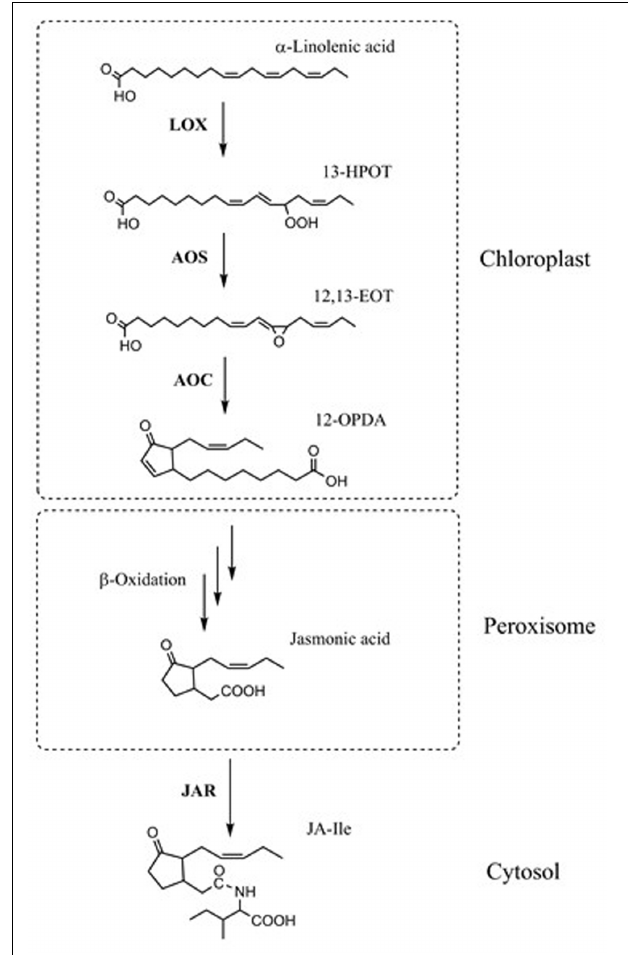
FIGURE 1 | Simplified JA biosynthetic pathway. α -Linolenic acid is oxygenated by 13-lipoxygenases (LOXs). In the 13-LOX pathway, the product (13 S )-hydroperoxy-octadecatrienoic acid (13-HPOT), is a substrate for allene oxide synthase (AOS). AOS converts 13-HPOT to (12,13 S )-epoxyoctade catrienoic acid (EOT). Allene oxide cyclase (AOC) converts EOT to cis -( + )-12-oxo-phytodienoic acid (12-OPDA). The OPDA is transported into peroxisome where it is converted to jasmonic acid (JA) by several rounds of β -oxidation. Jasmonic acid moves to the plant cytoplasm where it can be converted to ( + )-7- iso -jasmonoyl- L -isoleucine (JA-Ile) by